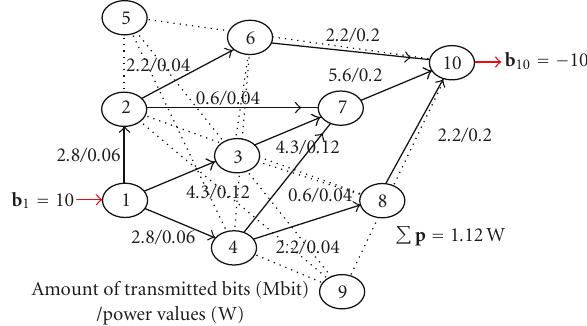
Figure 7: Network [1,3,5,1]: Average rate allocation, Bandwidth B =